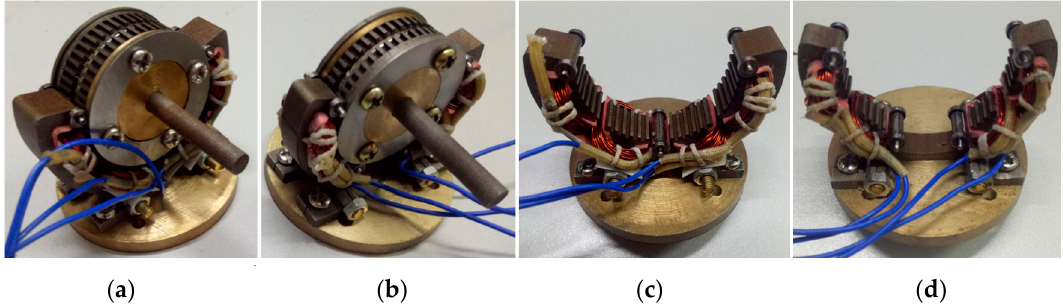
Figure 8. Prototypes of testing motors. ( a ) Testing motor of sub-motor1; ( b ) Testing motor of sub-motor2; ( c ) Stator of sub-motor1; ( d ) Stator of sub-motor2.